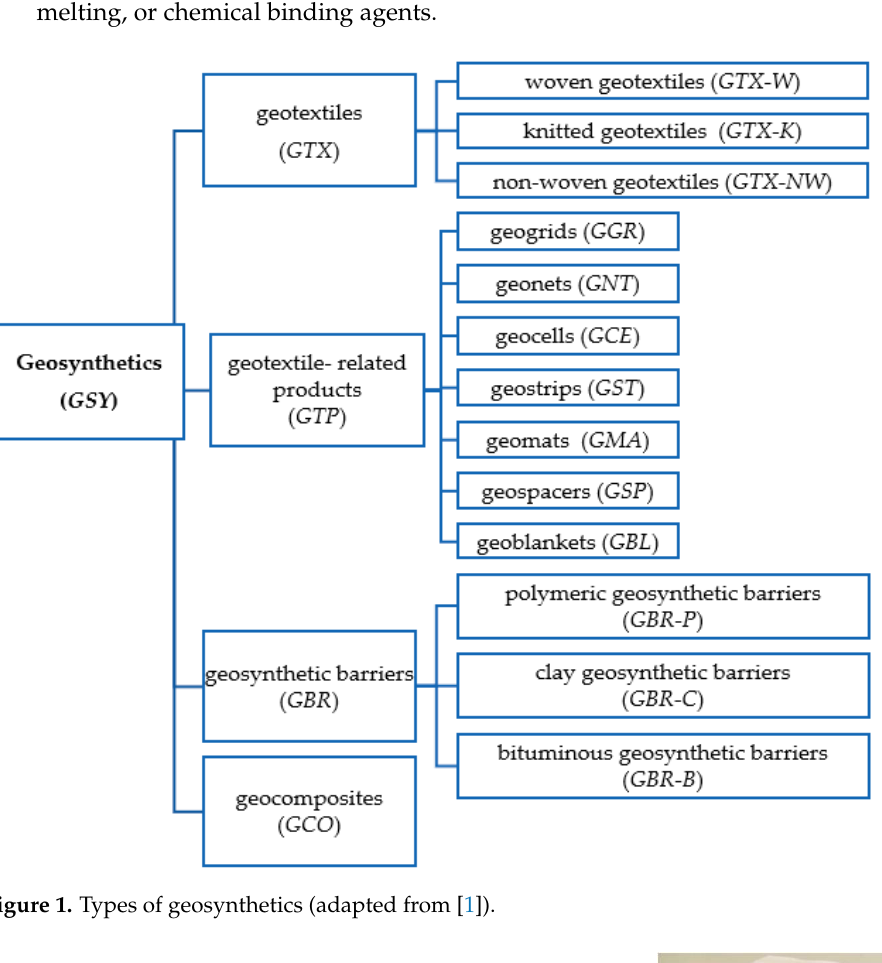
Figure 1. Types of geosynthetics (adapted from [1]).